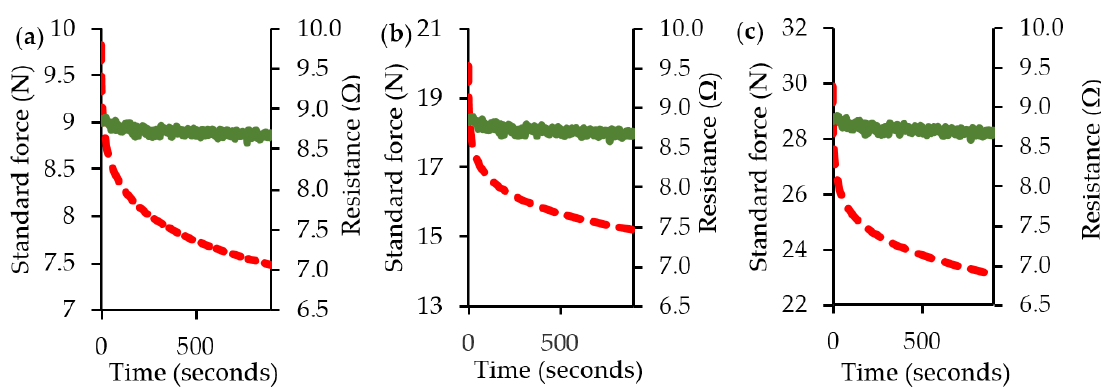
Figure 3. Force degradation (presented as a red dotted line) and electrical resistance (presented as a green line) as a func- tion of time for electrodes undergoing multiaxial loading. ( a ) 10 N loading force. ( b ) 20 N loading force. ( c ) 30 N loading